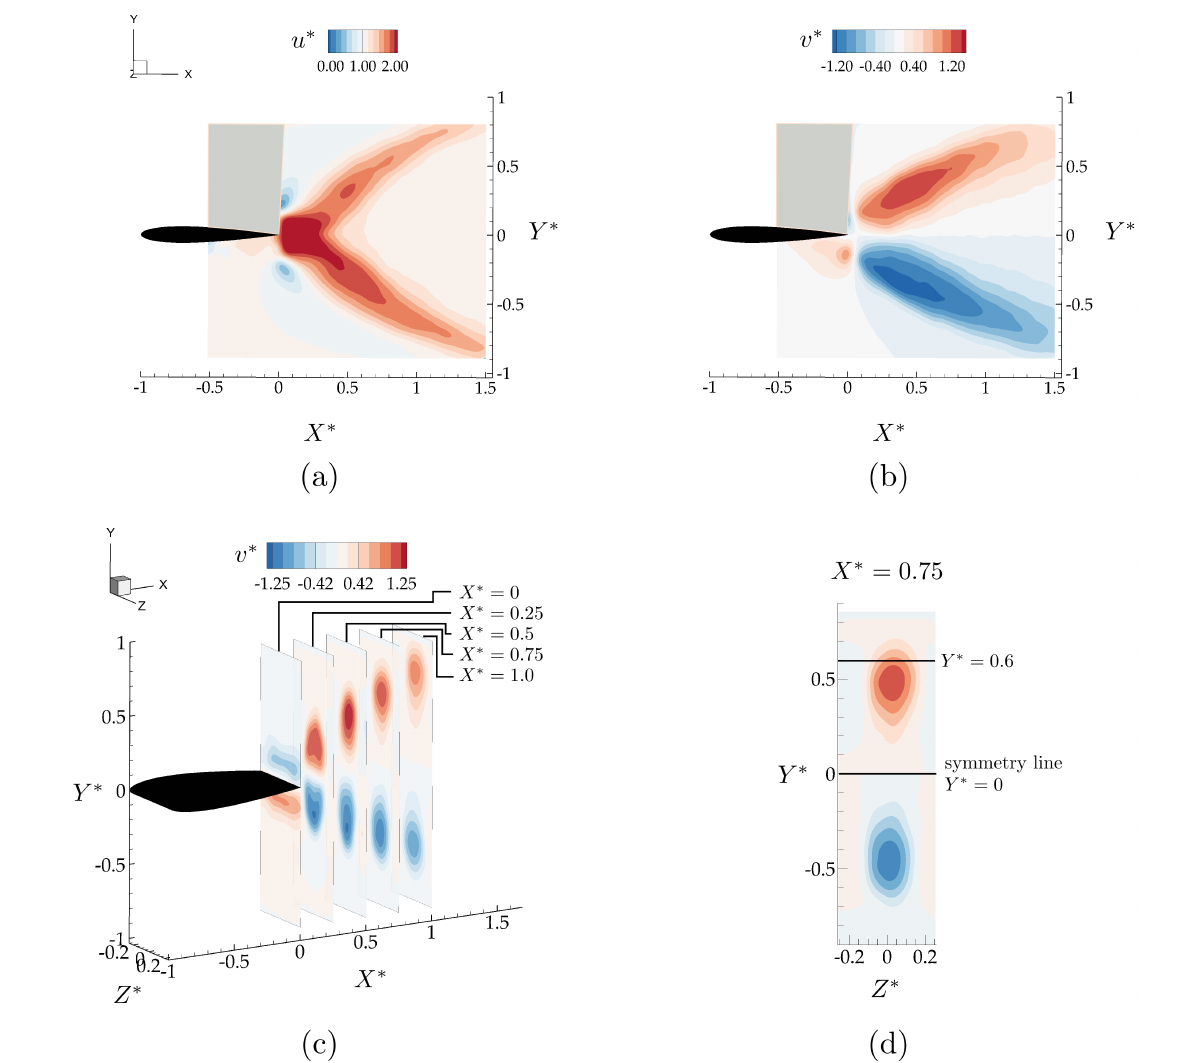
Figure 5. Time averaged velocity field components, ( u , v ) , normalized with the free-stream velocity, U , for the isolated wing in the mid-span plane ( a , b ), and different YZ planes ( c , d